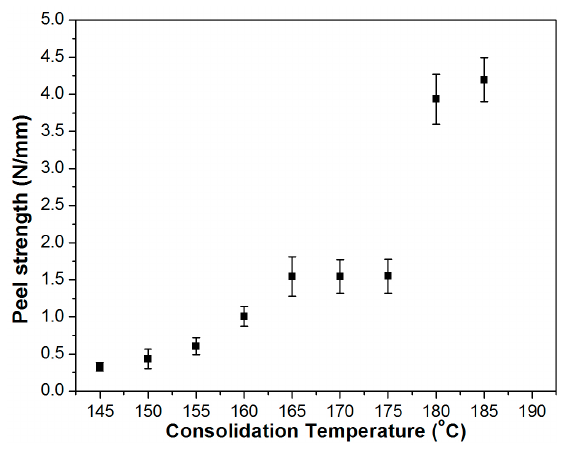
Figure 4. Peel strength of the UD SRCs prepared at different consolidation temperatures.